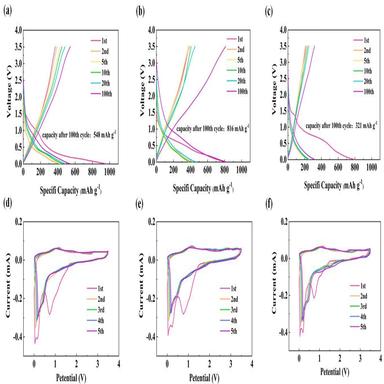
Charge-discharge curves at 1 A g− 1 for (a) Co/MnO-LC@C-600, (b) Co/MnO-LC@C-700, (c) Co/MnO-LC@C-800. Initial five CV curves of (d) Co/MnO-LC@C-600, (e)Co/MnO-LC@C-700, (f)Co/MnO-LC@C-800.